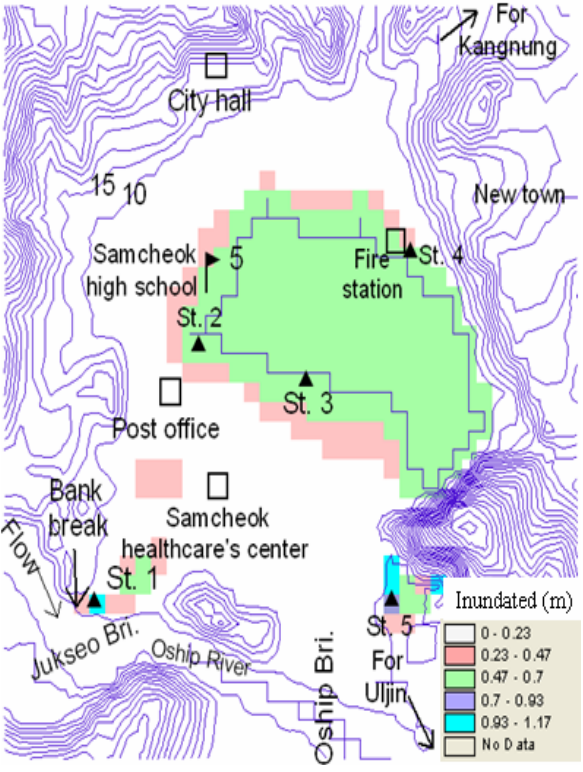
Fig. 7. Inundation depths obtained in the case of building influence